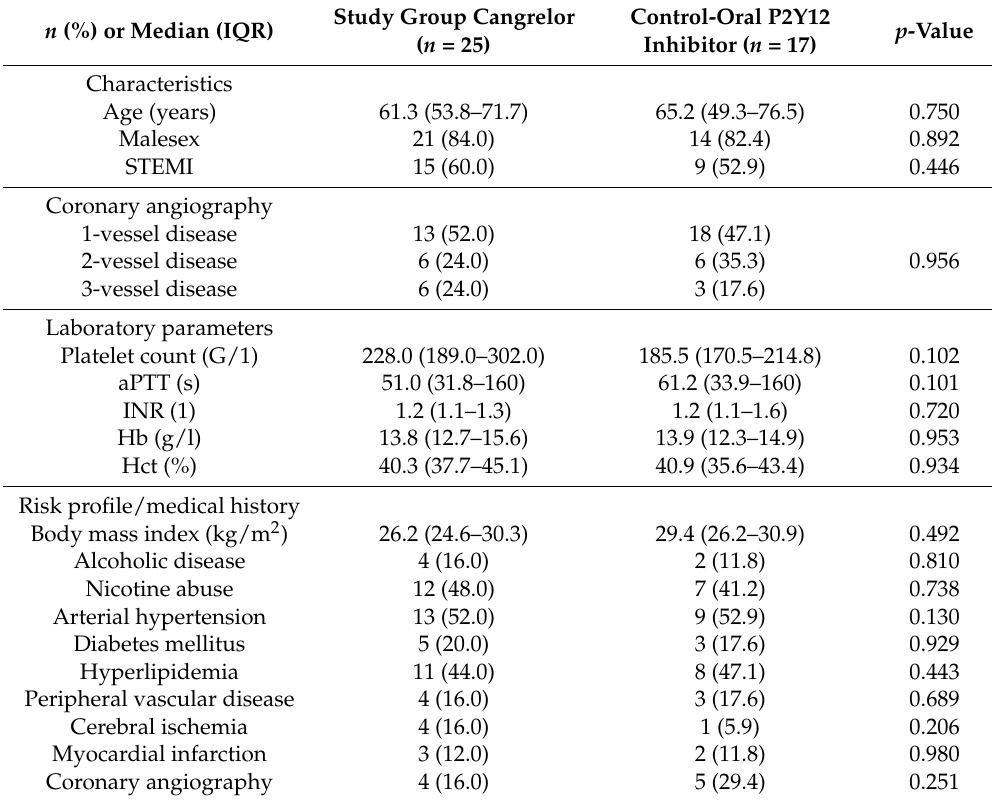
Table 1. Baseline characteristics, risk factors, and medical history data of the CANGRELOR group (left) and the ORAL P2Y12 group right. No significant differences could be detected between the